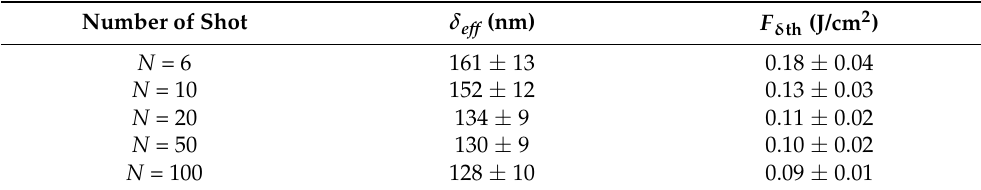
Figure 6. Similar to those in Figures 3–5 but for the modified cyanate ester resin (BS-4). ( a ) Optical microscopy of ablation craters; ( b ) statistics on diameter squared at different pulse peak fluences; ( c ) ablation depth as a function of pulse number; and ( d ) logarithm fit of ablation rate. Table 3. Depth-regression-based ablation threshold ( F δ th ) and effective energy penetration depth ( δ eff ) for the BS-4